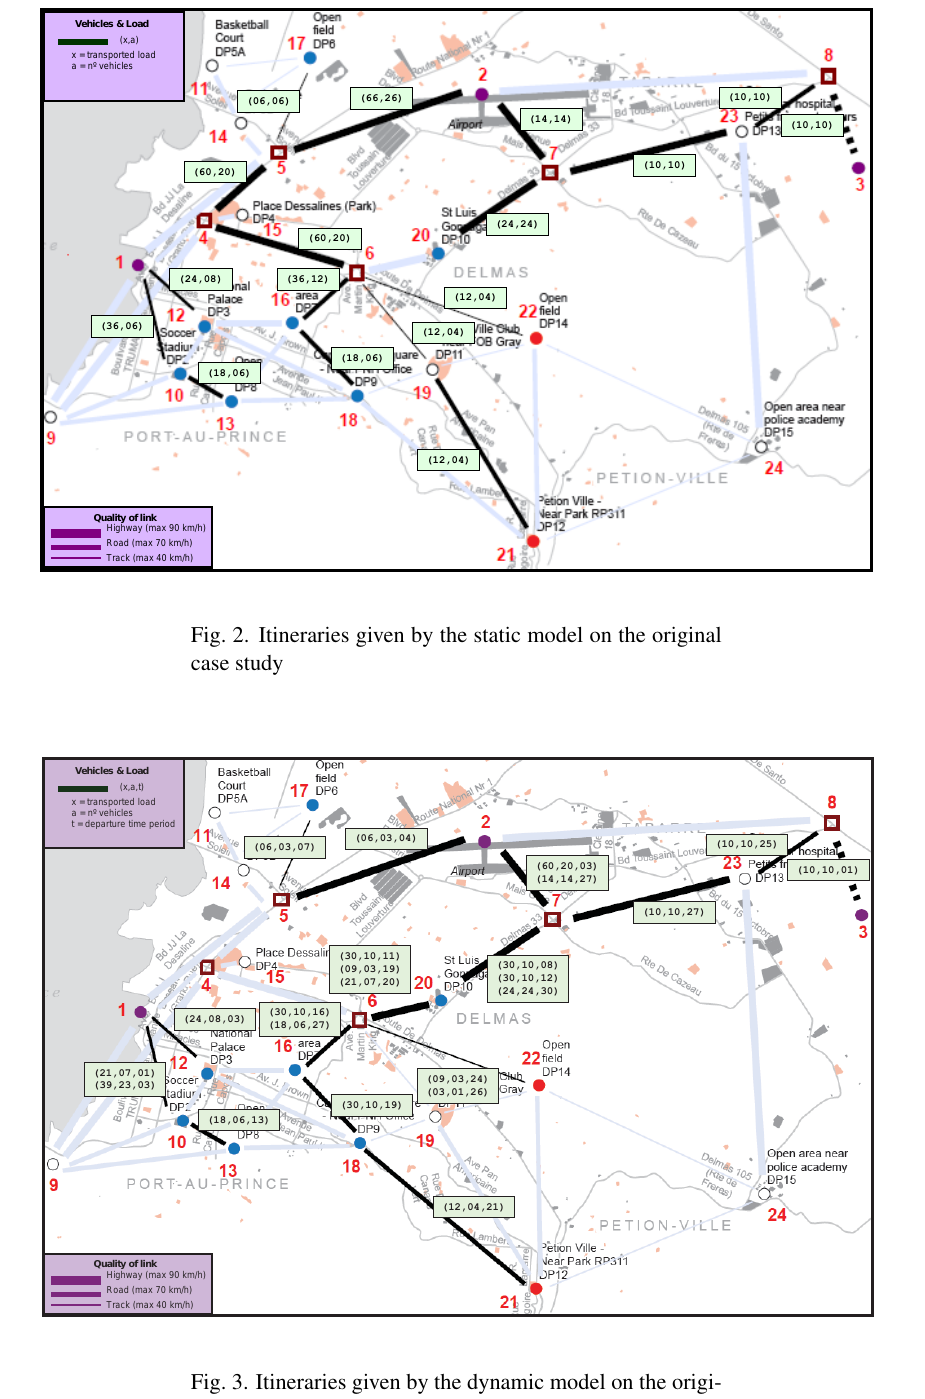
Fig. 3. Itineraries given by the dynamic model on the origi- nal case